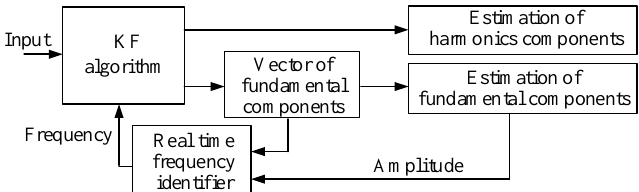
Figure 1. Tracking method based on KF algorithm with frequency identifier.